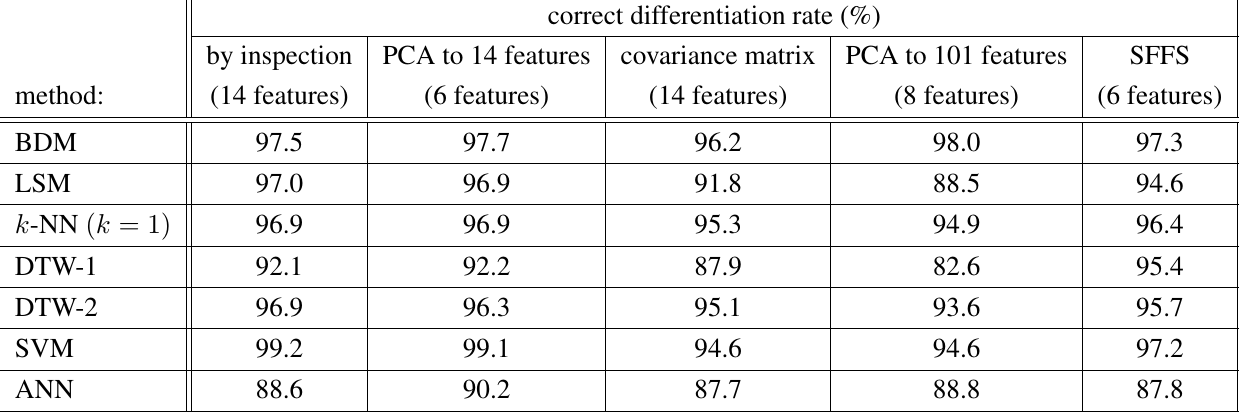
Table 3. Correct differentiation rates for different feature reduction methods and RRSS cross validation.